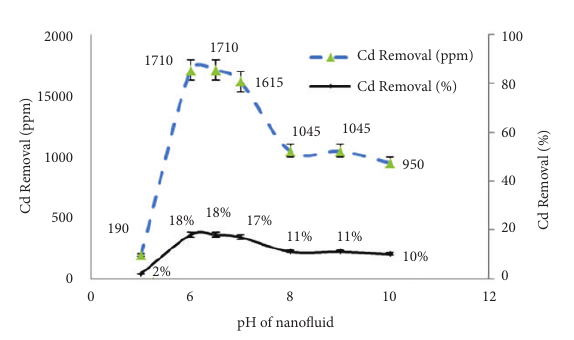
Figure 5. Removal of Cd by nanofluid at different pH (Concentration = 500 ppm, ratio of soil mass (gr) to nanofluid volume (mL) = 1:10, Contact time = 24